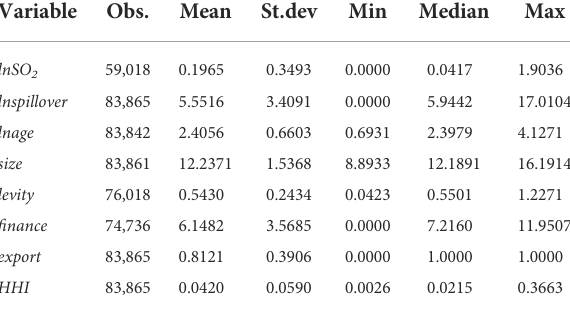
TABLE 1 Summary